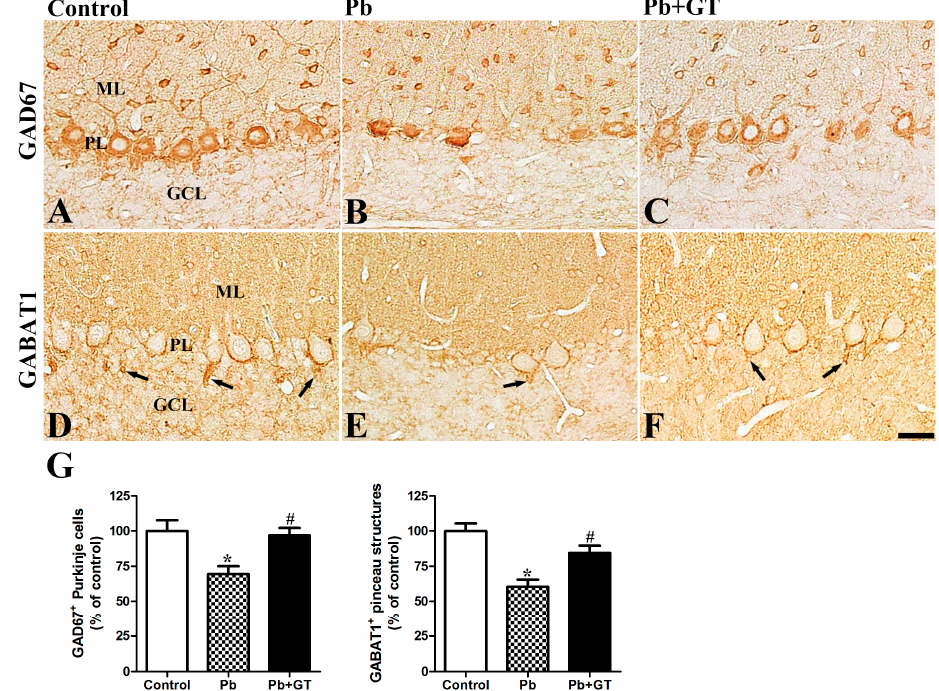
Figure 5. Effects of gintonin on Pb-induced changes in cerebellar GAD67 and GABA transporter1. Immunohistochemistry for GAD67 ( A–C ) and GABA transporter 1 (GABAT1) ( D–F ) in the cerebellum of offspring from control, lead (Pb), and Pb plus gintonin (Pb+GT) groups. Note that GAD67-immunoreactive Purkinje cells and GABAT1-positive pinceau structures (arrow) near Purkinje cells are detected in the cerebellar cortex and are significantly reduced in the Pb group; gintonin treatment attenuates these reductions in the Pb+GT group. GCL, granular cell layer; ML, molecular layer; PL, Purkinje cell layer. Bar = 25 μ m. ( G ) The number of GAD67-positive Purkinje cells ( p = 0.0017, one-way analysis of variance) and GABAT1-positive pinceau structures ( p < 0.0001, one-way analysis of variance) is expressed as a percentage of the value in the control group in the cerebellar cortex (n = 12 per group). * p < 0.05, compared to control group; # p < 0.05, compared to Pb alone, Tukey’s post-hoc test. The bars indicate means ± standard error of mean.